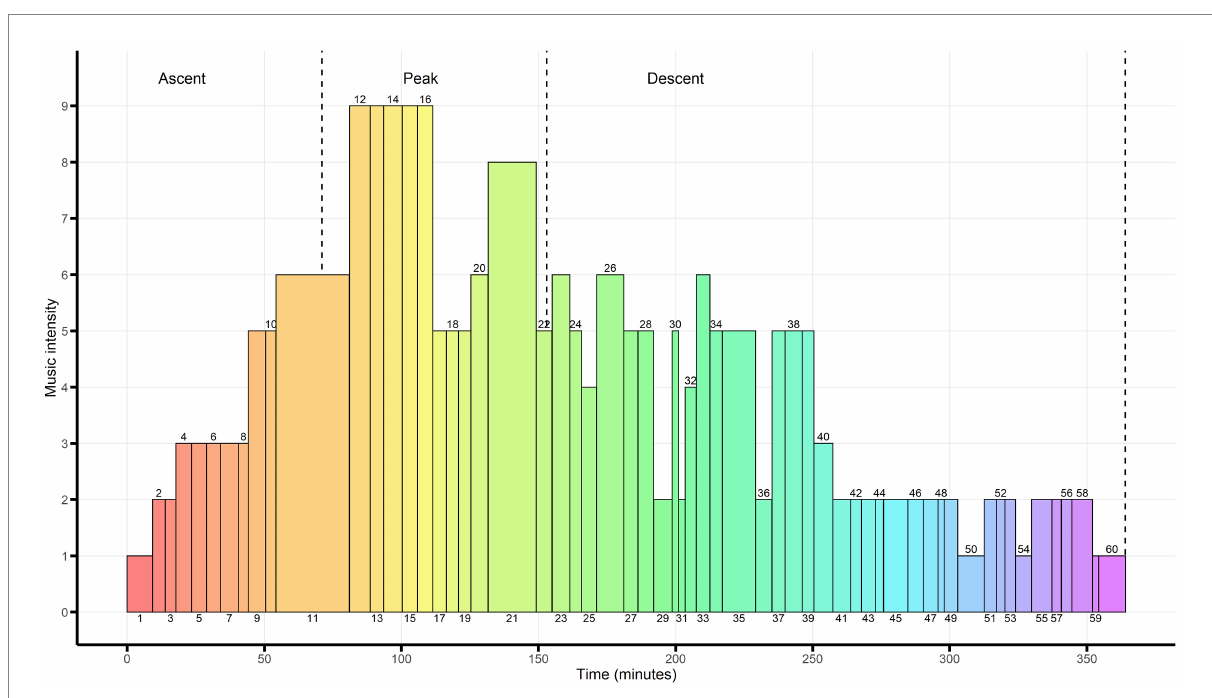
FIGURE 1 Intensity profile of the Copenhagen Music Program. Illustration of each of the 60 music pieces in the music program with intensity indicated on the y-axis and duration in time on the x -axis. Intensity of the music is measured by the Taxonomy of Therapeutic Music. Average time of the Ascent, Peak and Descent phases for a medium/high dose of psilocybin is indicated by the vertical dotted lines. Numbers in the figure refer to the place of each music piece in the music program. These numbers can also be found in Table 2 which provides a full overview of all the music